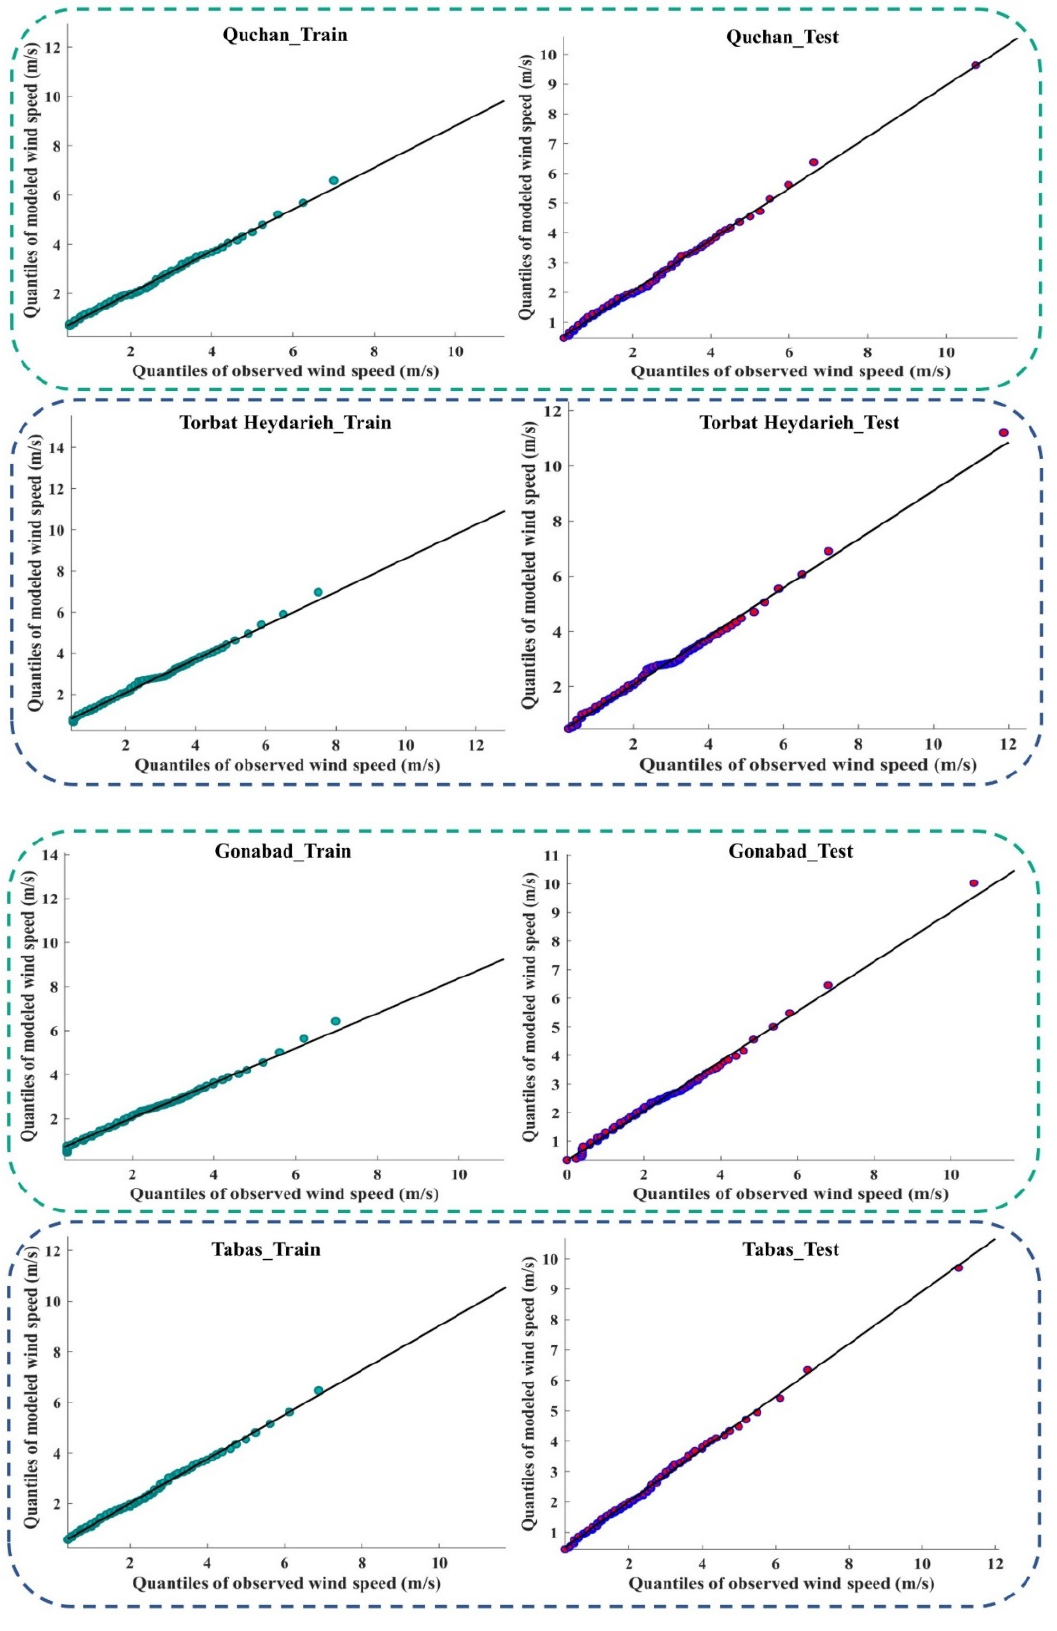
Figure 9. Q–Q plots of observed and modeled values of WS using the meta-algorithm at different stations.